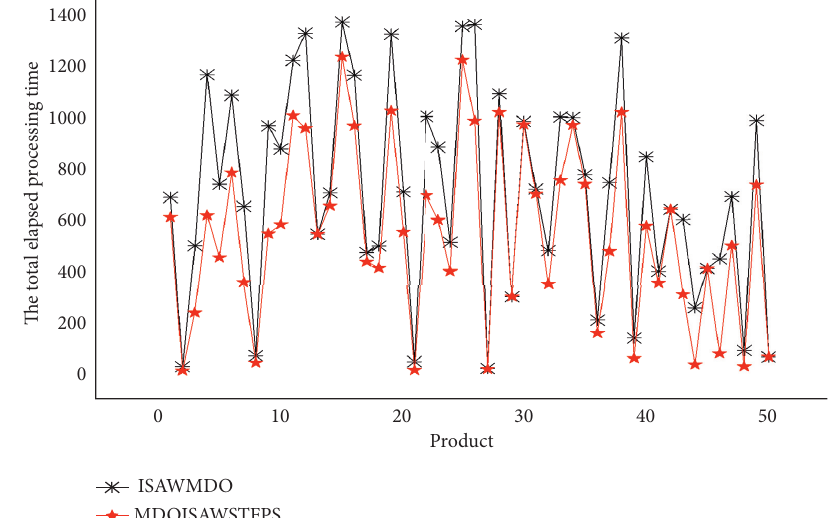
Figure 10: Comparison of the total elapsed processing time when the number of multiequipments is 2 for the two